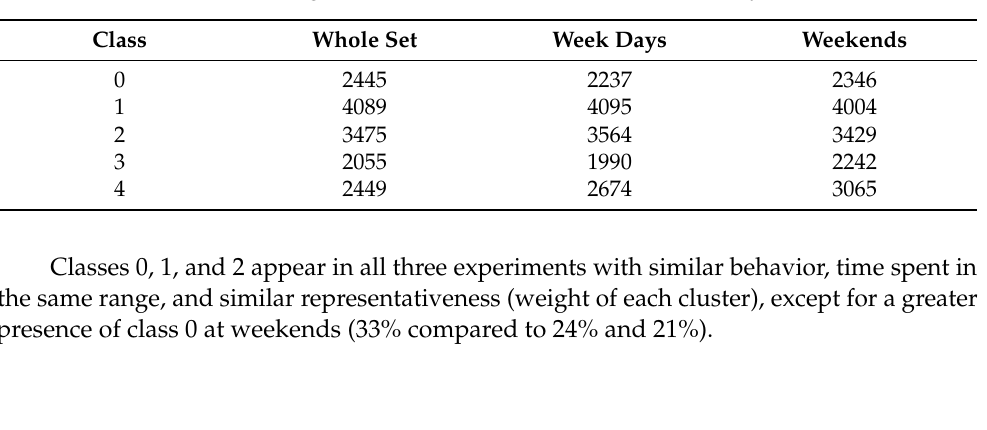
Figure 8. Detailed results for classes 0 to 4. The whole set of trajectories is on the left. Weekdays are in the center, and weekends on the right. Table 3. Detailed results. Average visit time, in seconds. Whole set, week days and